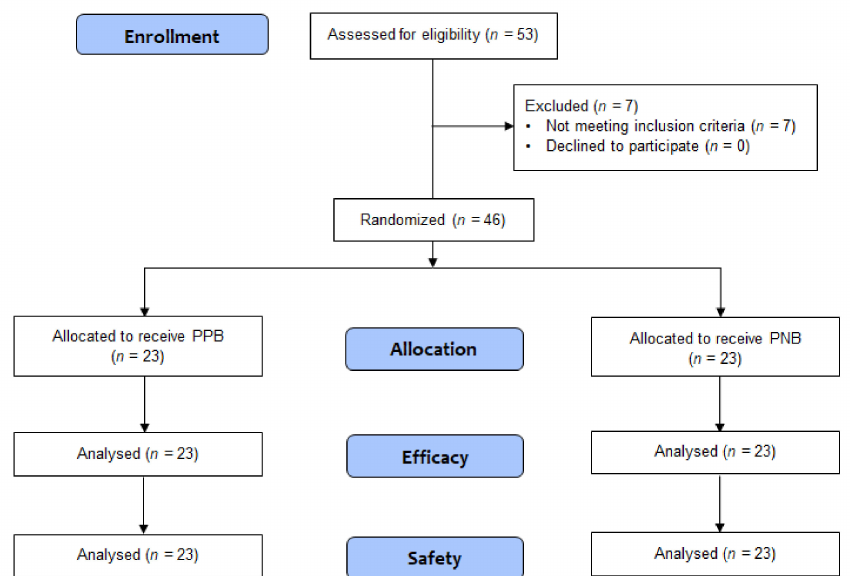
Figure 1. Consolidated standard of reporting trials flow diagram of study participants. PPB, pelvic plexus block; PNB, periprostatic nerve block.